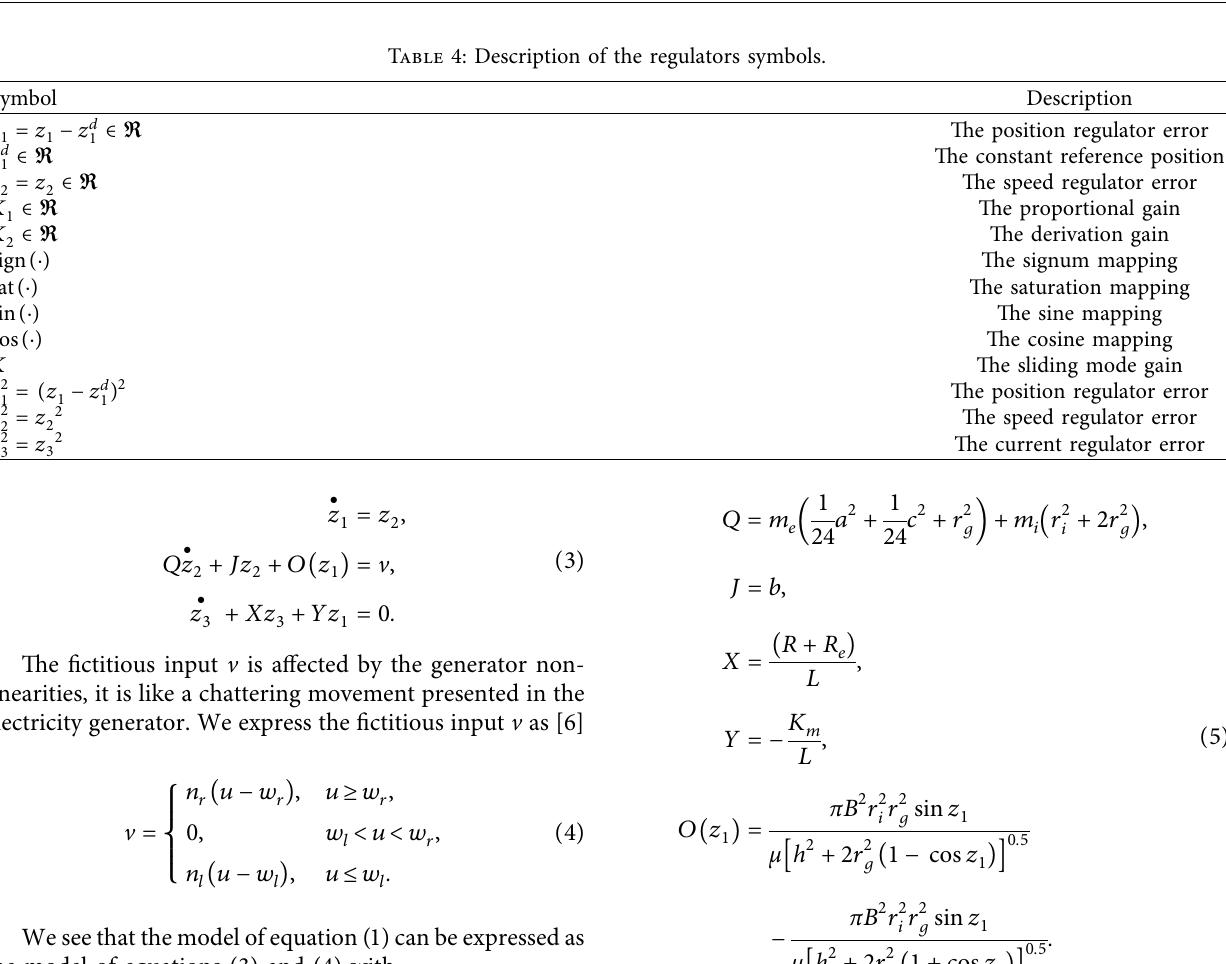
Table 4: Description of the regulators